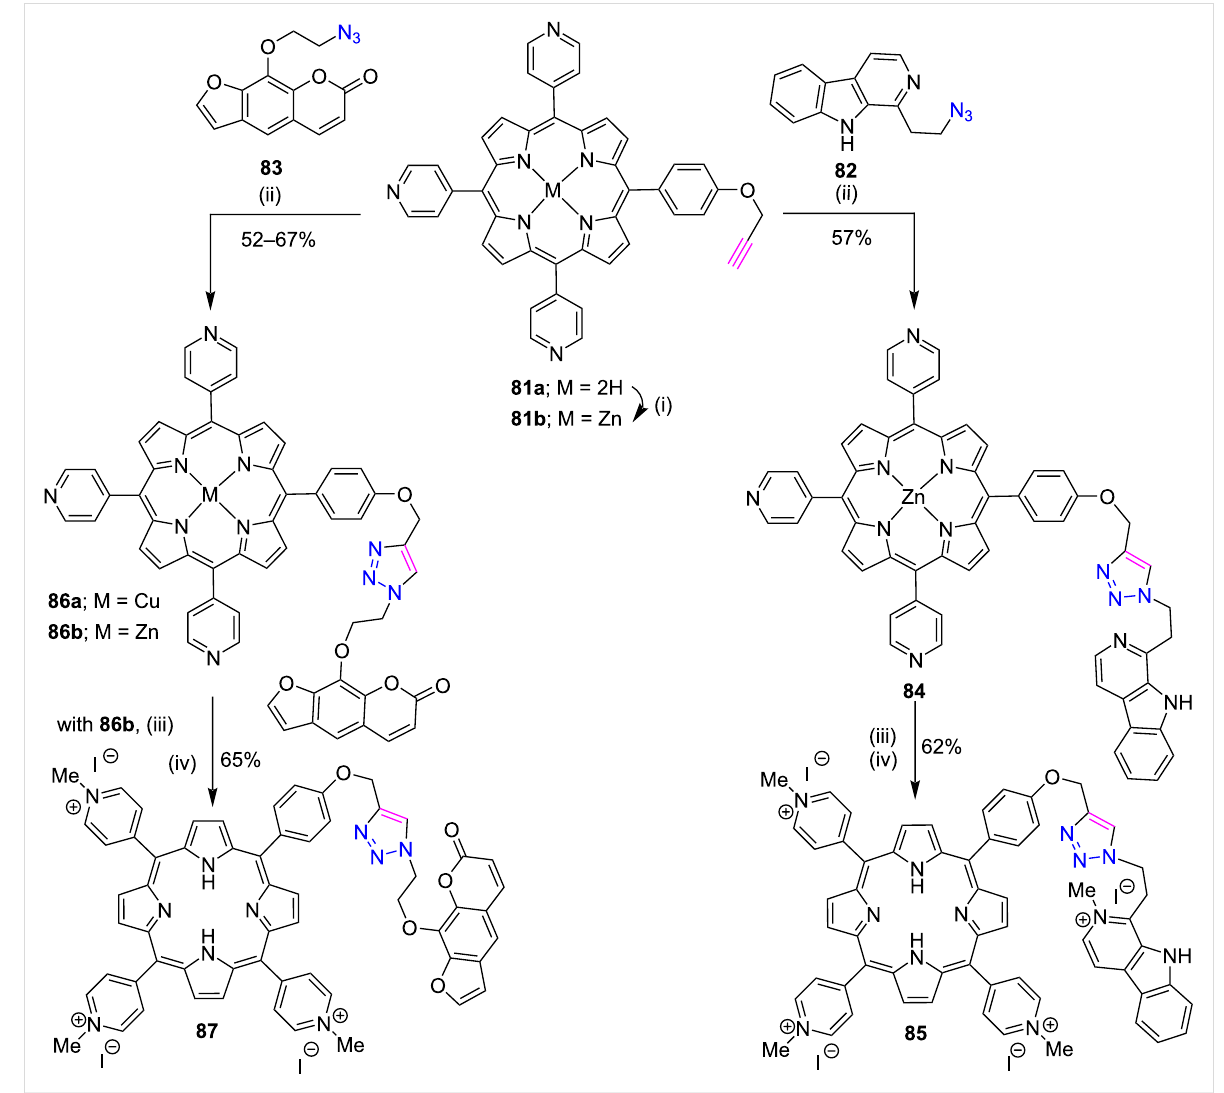
Scheme 17: Synthesis of meso - triazole-linked cationic porphyrin conjugates 85 and 87 . Reaction conditions: (i) Zn(OAc) 2 , CHCl 3 , MeOH, reflux, 2 h (ii) CuSO 4 ∙ 5H 2 O, sodium ascorbate, DMF/H 2 O (1:1), 80 °C, 32–168 h (iii) CHCl 3 , aq HCl (25%), 1 h (iv) MeI (120 equiv), DMF, rt, 36–72